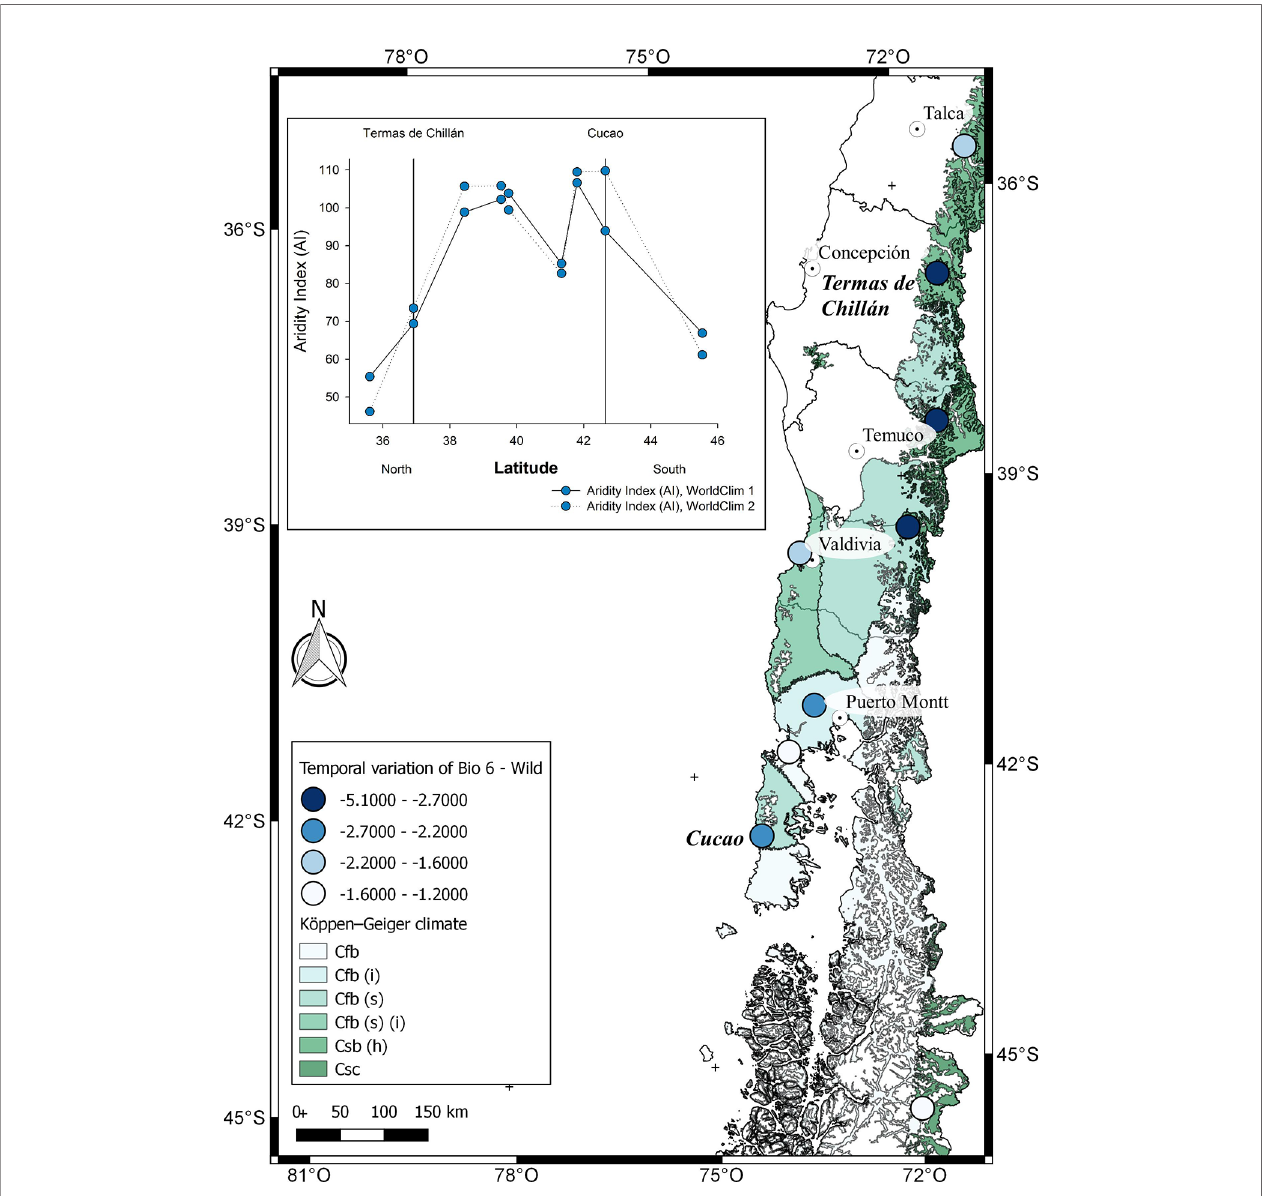
FIGURE 7 | Climatic characterization of the localities where F. chiloensis f. patagonica is distributed in Chile, from North to South. The comparison of Bioclimatic variable 6 (Min temperature of coldest month) between WorldClim 1 and 2 for each locality in which F. chiloensis f. patagonica grows are shown in the map. In the insert, De Martonne Aridity Index (AI) for each locality. On the X axis, the localities of Termas de Chilla ́ n and Cucao are marked as reference, as previously shown in Figure 1